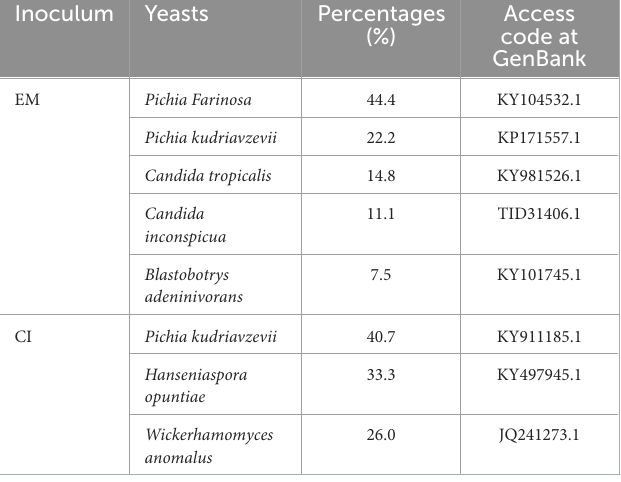
TABLE 3 Yeast present in EM and CI inoculum, quantification, and Genbank access code. Inoculum